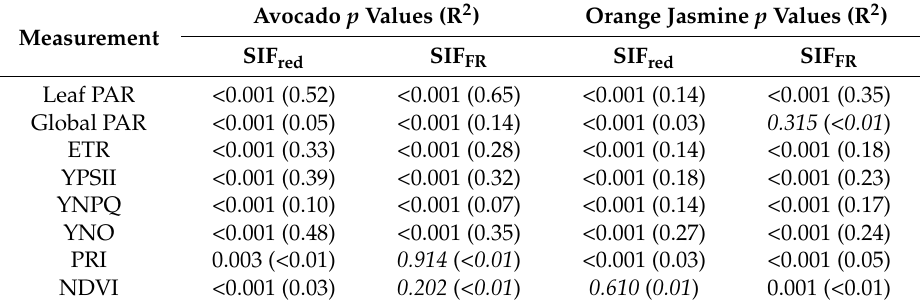
Table 1. Matrix table of p and R 2 values for correlations between SIF (red and far-red (FR)) and LIFT photosynthetic (ETR, YPSII, YNPQ, YNO), PAR (leaf and global) and spectral (PRI and NDVI) measurements, from two different species of plants (avocado ( n = 1266) or orange jasmine ( n = 986)), with measurements performed every 3 min and averaged for 6 leaves of each species. For each correlation the p value is given followed by the R 2 value in brackets; where insignificant, correlations are italicized. p values should be interpreted with caution due to pseudo-replication of measurements (3 min